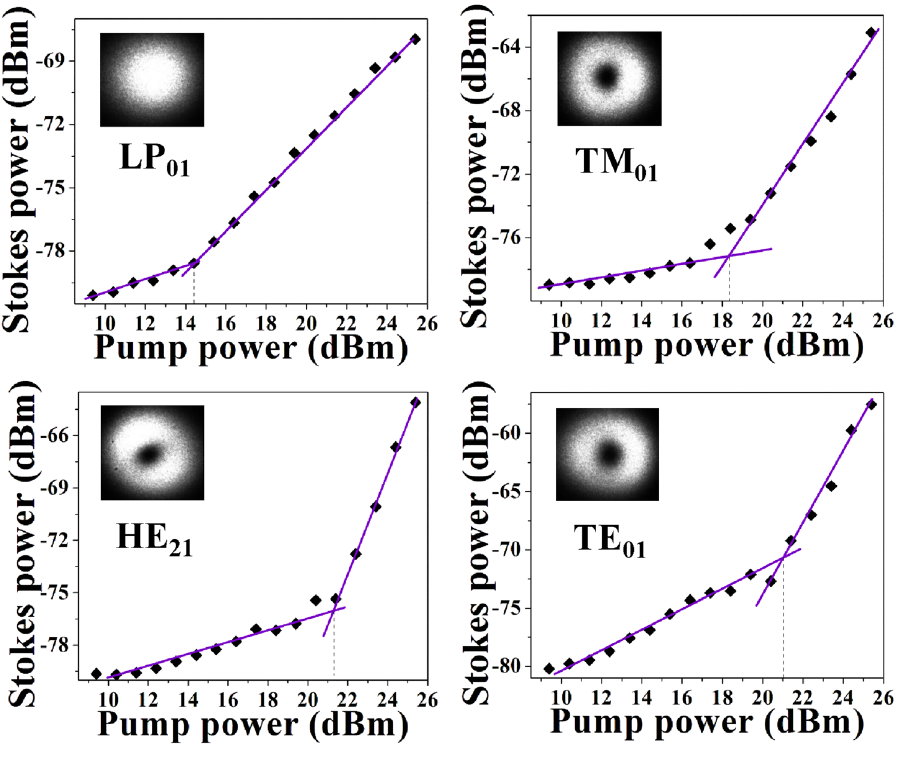
Figure 6. Brillouin threshold power of the LP 01 , TM 01 , HE 21 and TE 01 modes in the